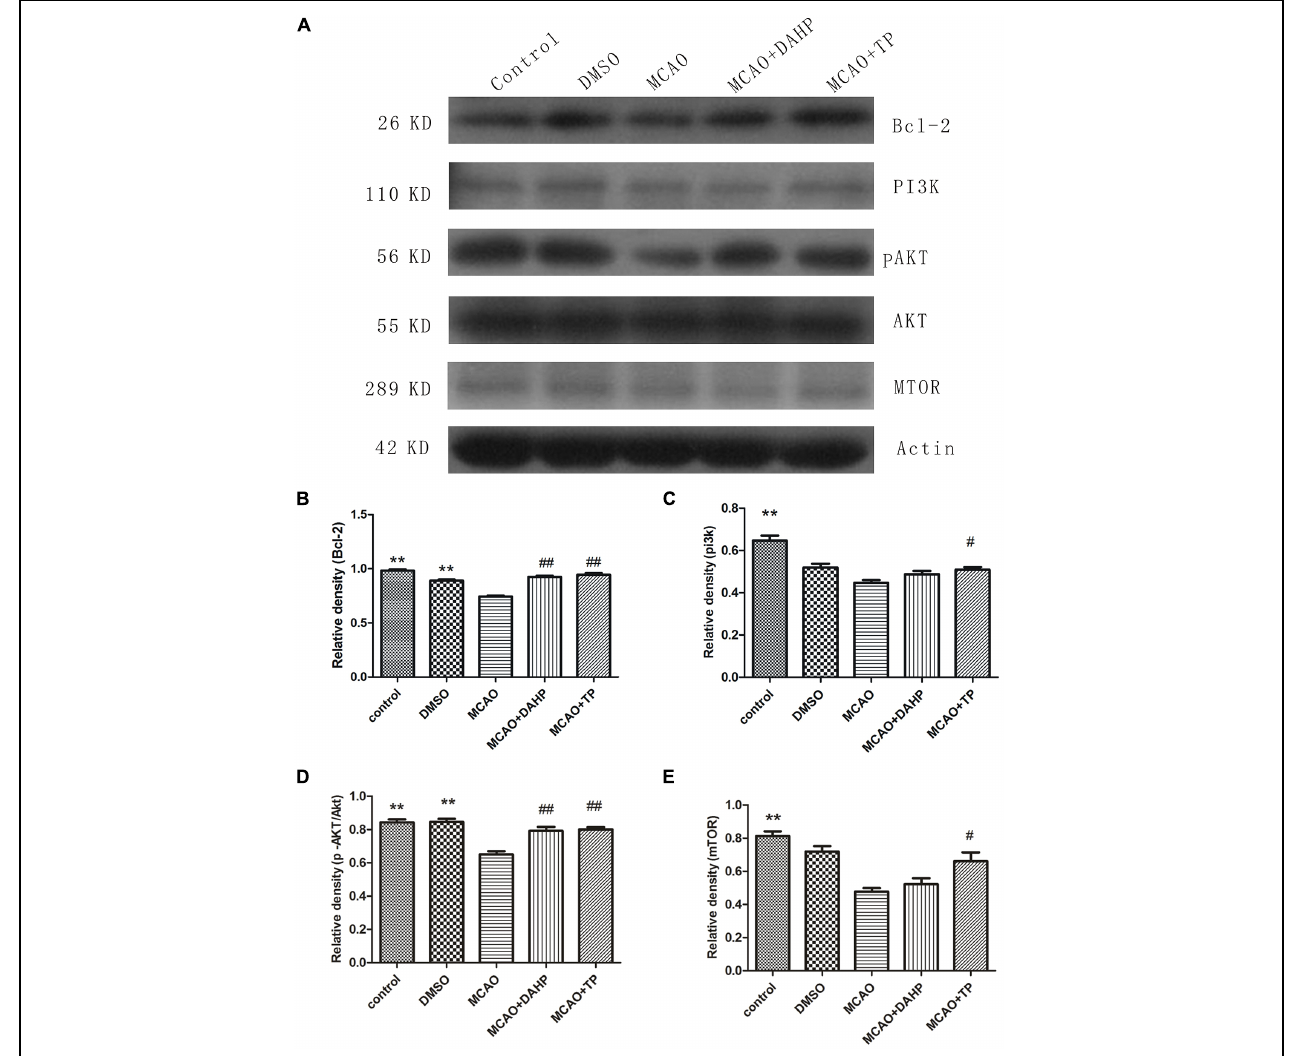
FIGURE 6 | 2, 4-diamino-6-hydroxypyrimidine and TP treatments rescued the decreased levels of PI3K, phosphorylated Akt Ser-473, and mTOR induced by ischemia in the cortex and hippocampus, also restored the decreased level of Bcl-2 induced by ischemia. (A) Compared with the control group, the PI3K, Akt,